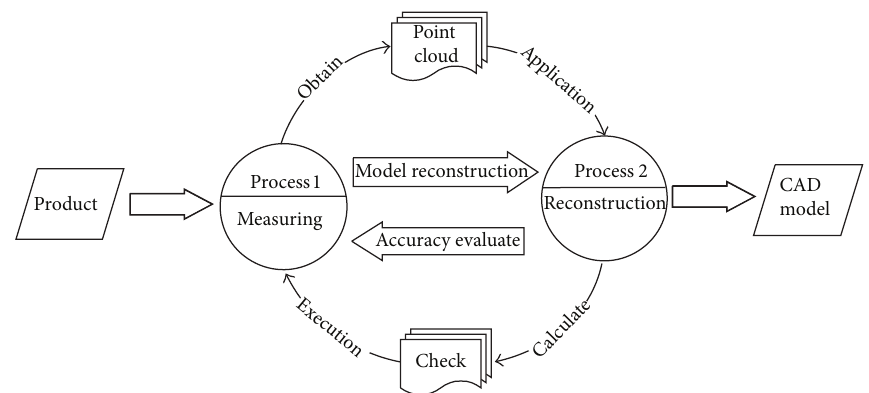
Figure 2: Reverse process based on the theory of closed-loop.